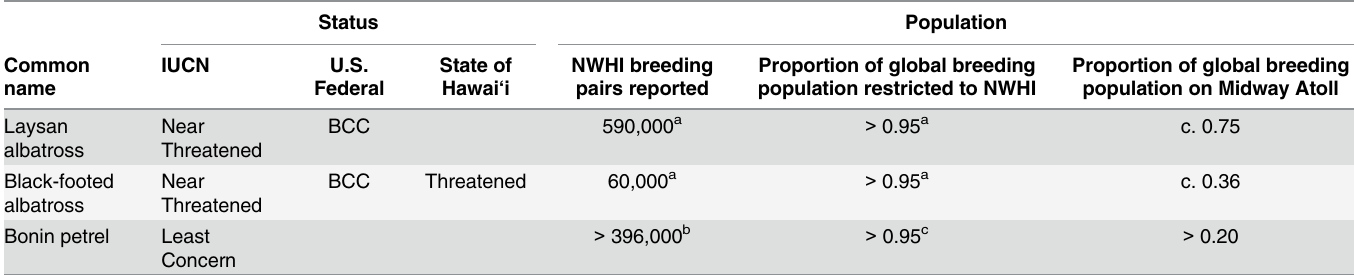
Table 1. Conservation status (2015) and population status of albatrosses ( Phoebastria immutabilis and P . nigripes ) and Bonin petrels ( Pterodroma hypoleuca ) in the Northwestern Hawaiian Islands (NWHI). Compiled from the International Union for Conservation of Nature [65], the US Fish and Wildlife Service (USFWS) Endangered Species Program [66] and its list of Birds of Conservation Concern (BCC; [67]), and the State of Hawai ‘ i, Department of Land and Natural Resources